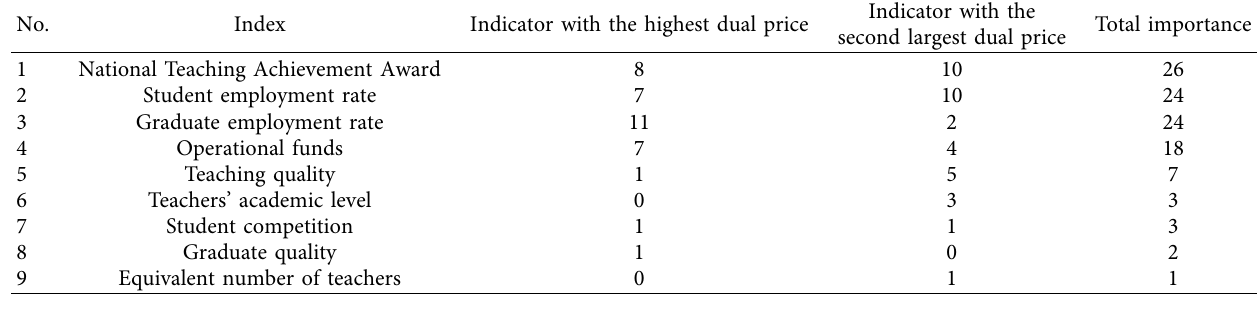
Table 8: Frequency statistics of indicators related to the largest and second largest dual price.